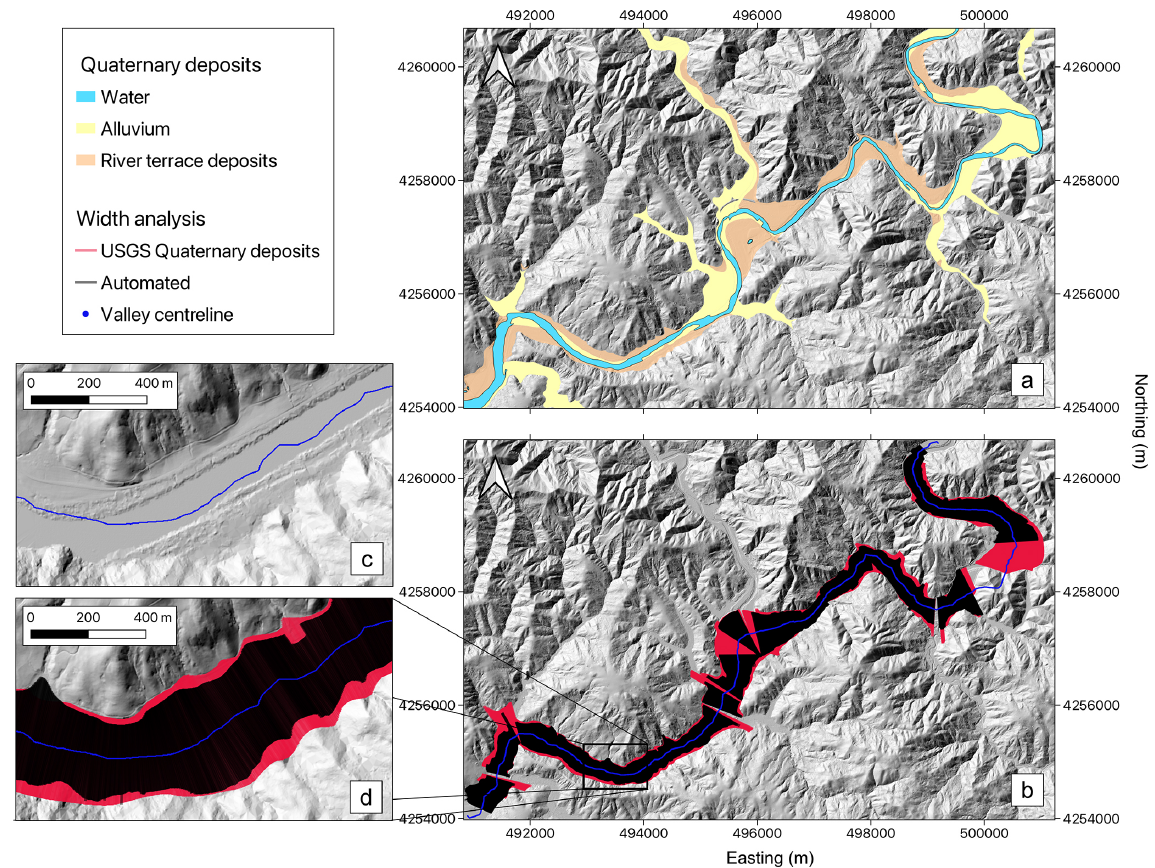
Figure 9. (a) Hillshade of the Russian River showing the extent of superficial Quaternary deposits mapped by the USGS from Knudsen et al. (2000). (b) Valley floor widths extracted using the automated method (black) and those derived from the USGS Quaternary maps (red). The valley centreline is shown in blue. Note the section of the channel to the east of the map (around UTM 500000, 4258000) where the centreline goes across hillslopes: this is due to an isolated hill in the middle of the valley, which obstructs the extraction of an accurate centreline. The zoomed images in panels (c) and (d) show the typical width distribution for the site, where the automated widths are generally narrower than those derived from the USGS maps. These show that USGS Quaternary maps tend to include hillslope toes as part of the Quaternary deposits (c) . The coordinate system is WGS84 UTM zone